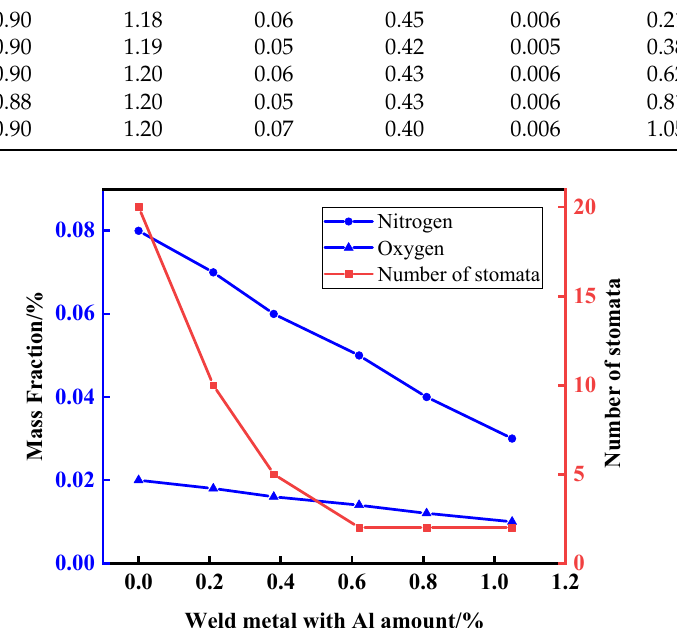
Figure 4. Effect of Al on oxygen and nitrogen content and porosity sensitivity of weld metal.